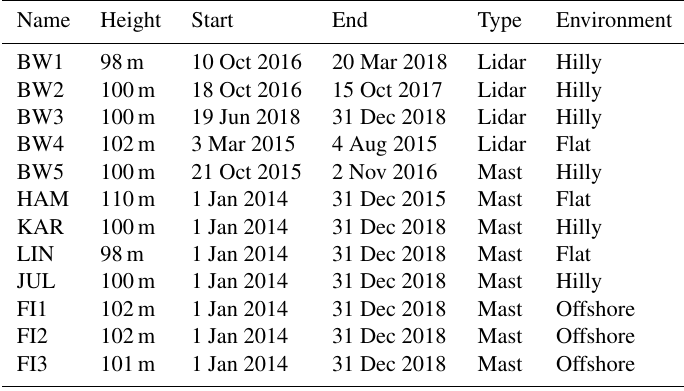
Table 1. Overview of mast and lidar observations.